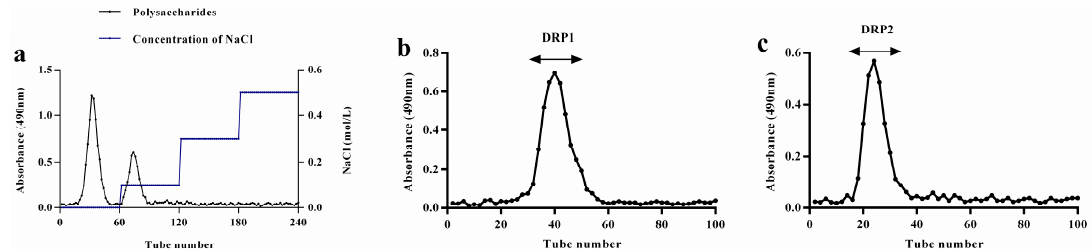
Figure 1. Anion-exchange chromatogram of the crude DRP on a DEAE-52 cellulose column ( a ), and gel filtration chromatograms of DRP1 ( b ) and DRP2 ( c ) on Sephacryl TM S-200 column.